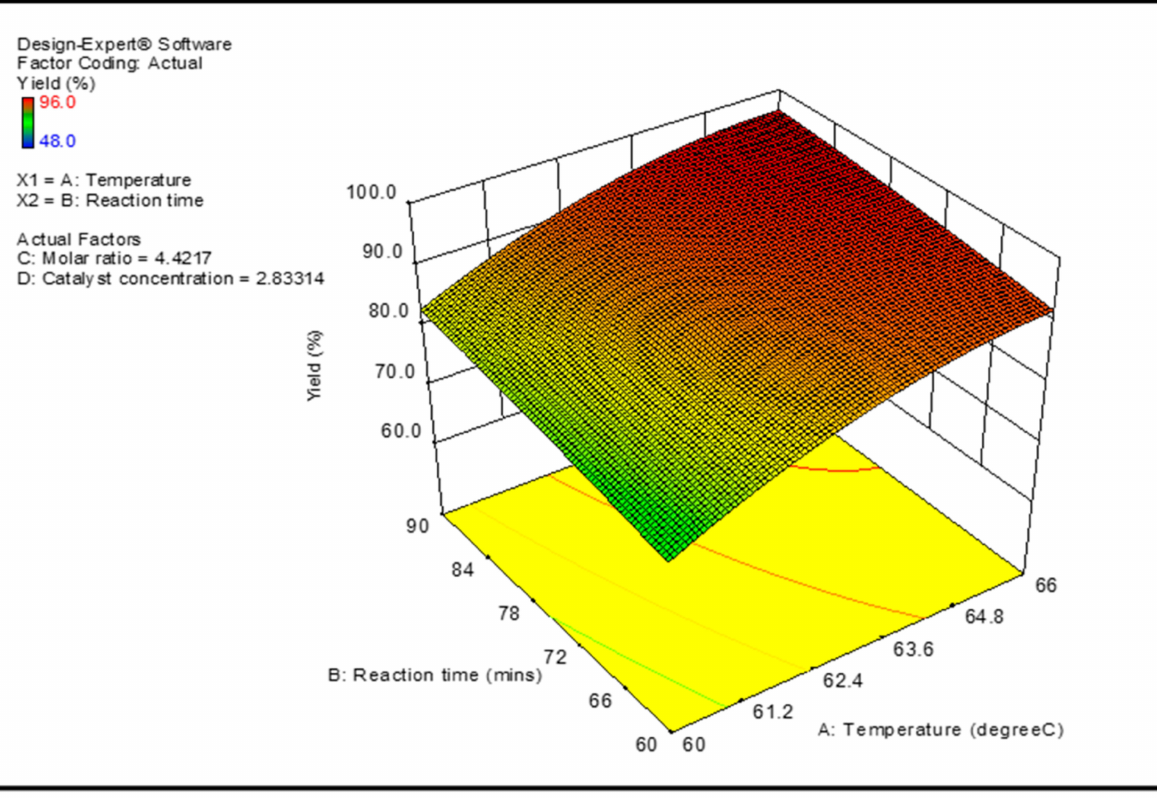
Figure 7. Projected biodiesel production against reaction time and temperature on a response surface 3D